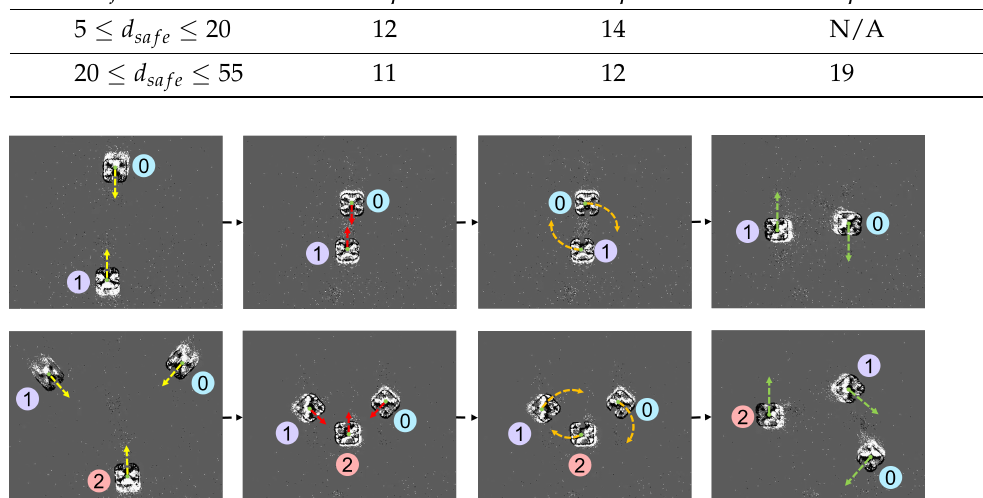
Figure 10. The motion capture system was used to test collision avoidance using a decentralized optimization-based motion planner. In each flight test, the quadrotors were able to successfully avoid d safe violations. Flight tests involved 2 quadrotors ( top panel of images) and 3 quadrotors ( bottom panel of images) flying toward each other. All quadrotors were operating between the speeds of 0.2 m/s and 1 m/s as determined by their respective motion